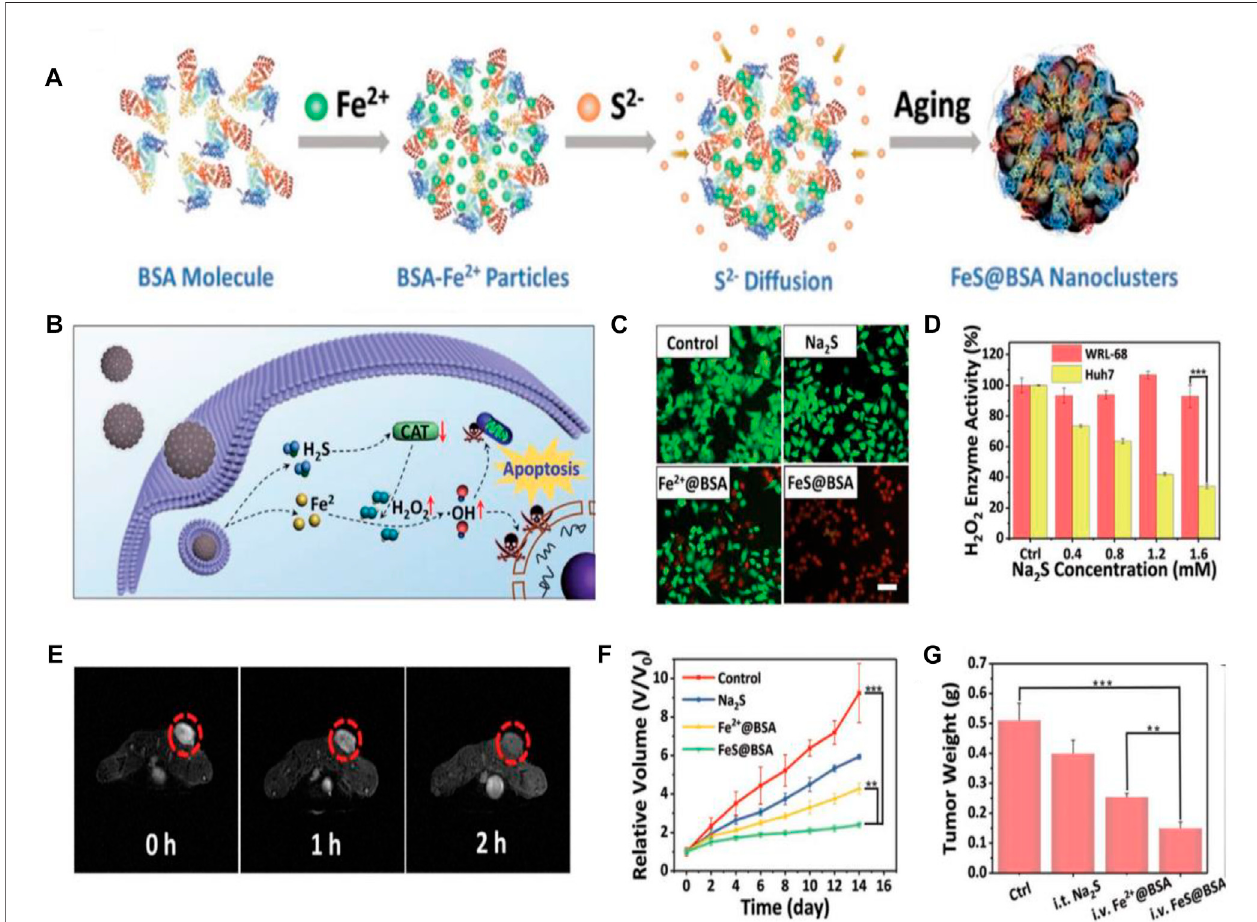
FIGURE 5 | Chemodynamic therapy (CDT)-based cancer theranostics. (A) Schematic illustration of the synthesis procedure of FeS@BSA nanoclusters. (B) Schematic illustration of synergistic antitumor mechanism of FeS@BSA nanoclusters. (C) LIVE/DEAD cell staining of Huh7 cells with calcein-AM/propidium iodide after incubation with PBS, Na 2 S, Fe 2+ @BSA, and FeS@BSA for 24 h. Scale bar is 20 μ m. (D) Suppression effect of H 2 S on intracellular H 2 O 2 enzyme activity in WRL-68 and Huh7 cells after incubation with Na 2 S (H 2 S donor). (E) T 2 -weighted MR images of Huh7 tumor-bearing nude mice before and after i.v. injection of FeS@BSA. (F) Tumor growth curves in mice from different treatment groups. (G) Weight of the excised tumors in different treatment groups after the 14 days of treatment. * p < 0.05, ** p < 0.01, *** p < 0.001. Reproduced with permission from Xie et al. (2020). Copyright 2020, WILEY-VCH Verlag GmbH and Co. KGaA, Weinheim.